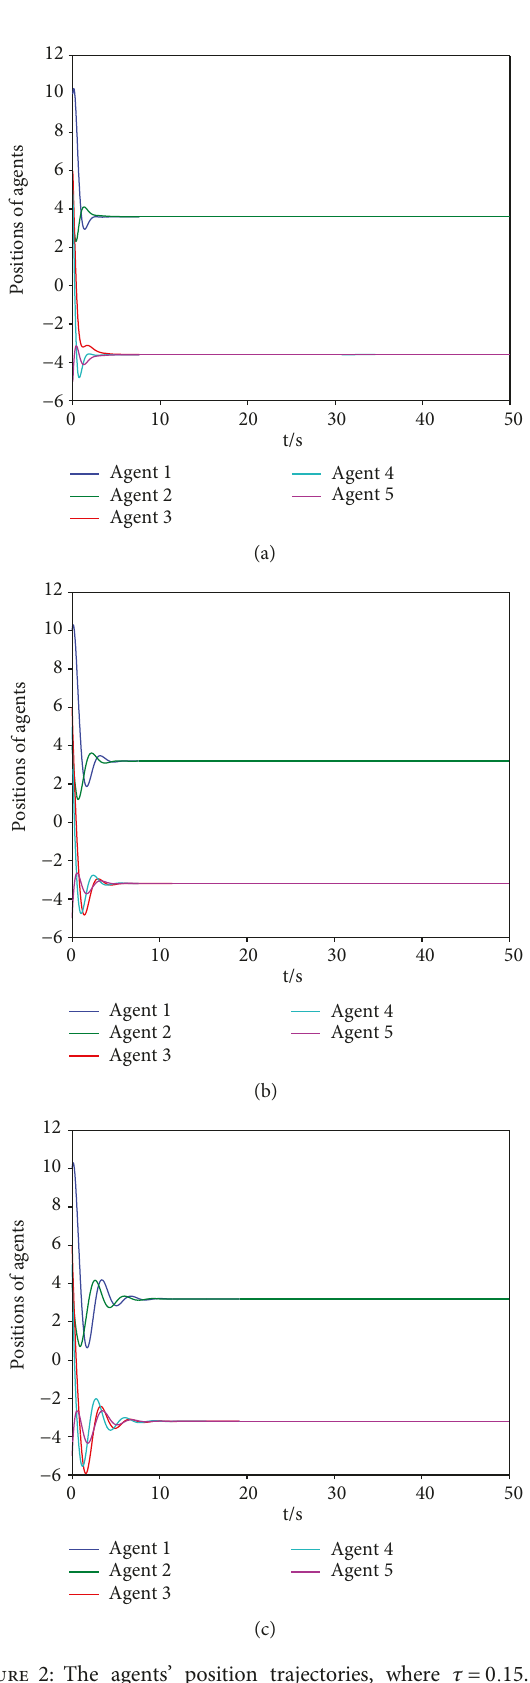
Figure 2: The agents ’ position trajectories, where τ = 0 15 . (a) τ